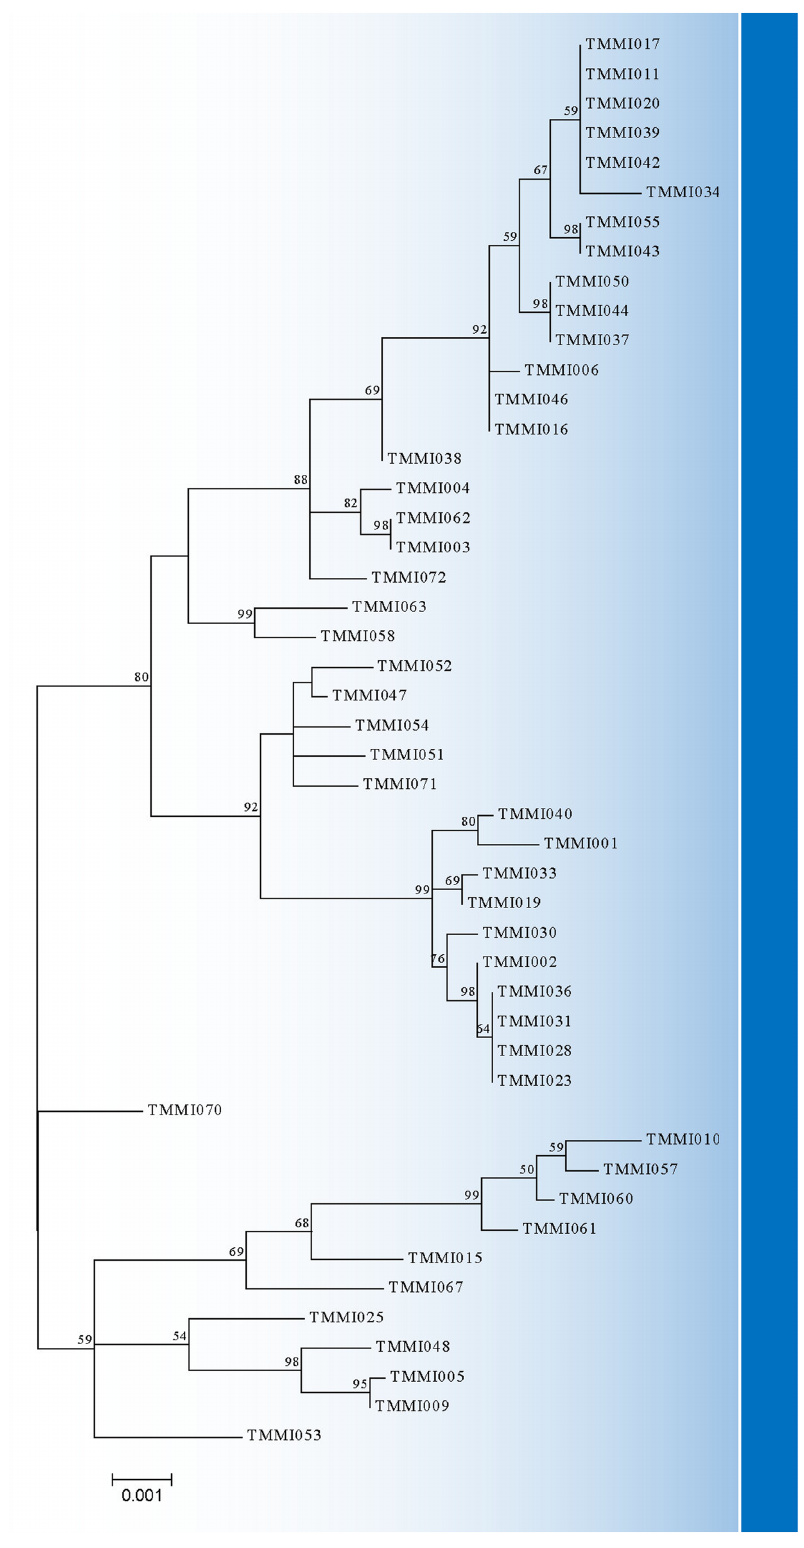
Fig 2. Molecular phylogenetic maximum likelihood analysis of the concatenated sequences of ACT, CAL, RPB2, BT2, SOD2, ITS, TEF-1 α , and TUB genes. The tree with the highest log likelihood(-8390.7037) is